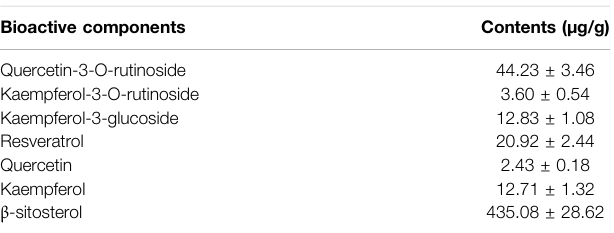
TABLE 1 | Contents of each bioactive component in EFT ( n (cid:2) 3). Bioactive